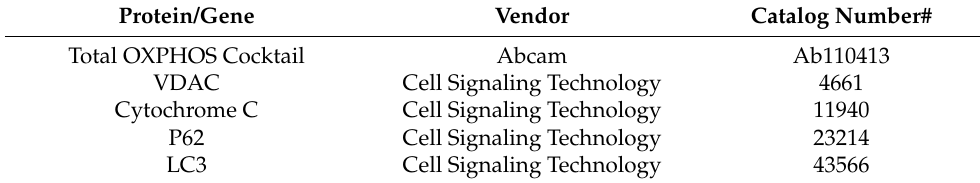
Table 1. Antibodies and probes